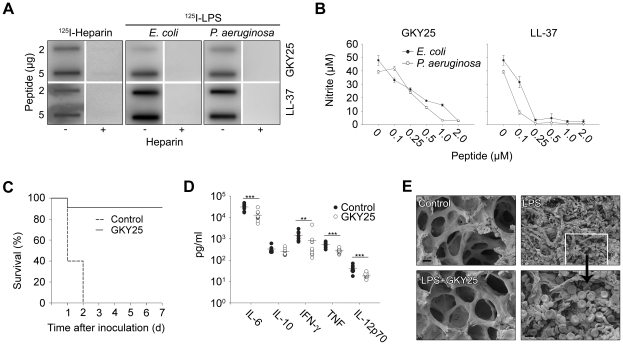
LPS-binding and immunomodulatory role in vitro and in vivo of thrombin-derived C-terminal peptides.(A) GKY25 binds heparin and LPS. 2 and 5 µg GKY25 were applied to nitrocellulose membranes. These membranes were then blocked in PBS (containing 2% bovine serum albumin) for 1 h at room temperature and incubated in PBS with iodinated (125I) heparin or LPS. Unlabeled heparin (6 mg/ml) (+) was added for competition of binding. LL-37 was used for comparison. The membranes were washed (3×10 min in PBS). A Bas 2000 radioimaging system (Fuji) was used for visualization of radioactivity. (B) GKY25 inhibits NO production. RAW264.7 macrophages were stimulated with LPS from E. coli and P. aeruginosa, in presence of GKY25 at the indicated concentrations. LL-37 is presented for comparison. (C) GKY25 significantly increases survival in LPS-induced shock. Mice were injected with LPS followed by intraperitoneal administration of GKY25 (200 µg). Survival was followed for 7 days. (n = 9 for controls, n = 10 for treated animals, P<0.001). (D) GKY25 attenuates proinflammatory cytokines. In a separate experiment, mice were sacrificed 6 h after i.p. injection of LPS followed by treatment with GKY25 (200 µg) or buffer, and the indicated cytokines were analyzed in blood (n = 9 for controls, n = 10 for treated animals, the P values for the respective cytokines are IL-6, 0.001; IFN-γ = 0.009; TNF, 0.001; IL-12p70, 0.001. IL-10 was not significant.). (E) Lungs were analyzed by scanning electron microscopy 20 h after LPS injection i.p., followed by treatment with GKY25 (200 µg) or buffer. Treatment with the peptides blocked leakage of proteins and erythrocytes (see inset) (n = 3 in both groups, and a representative lung section is shown).